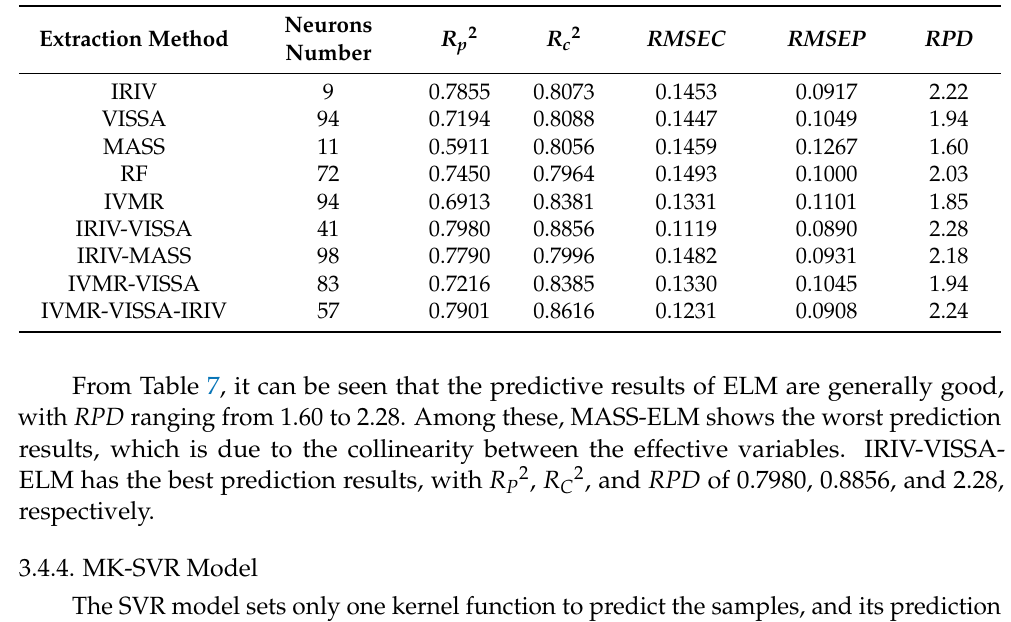
Table 7. The prediction results of